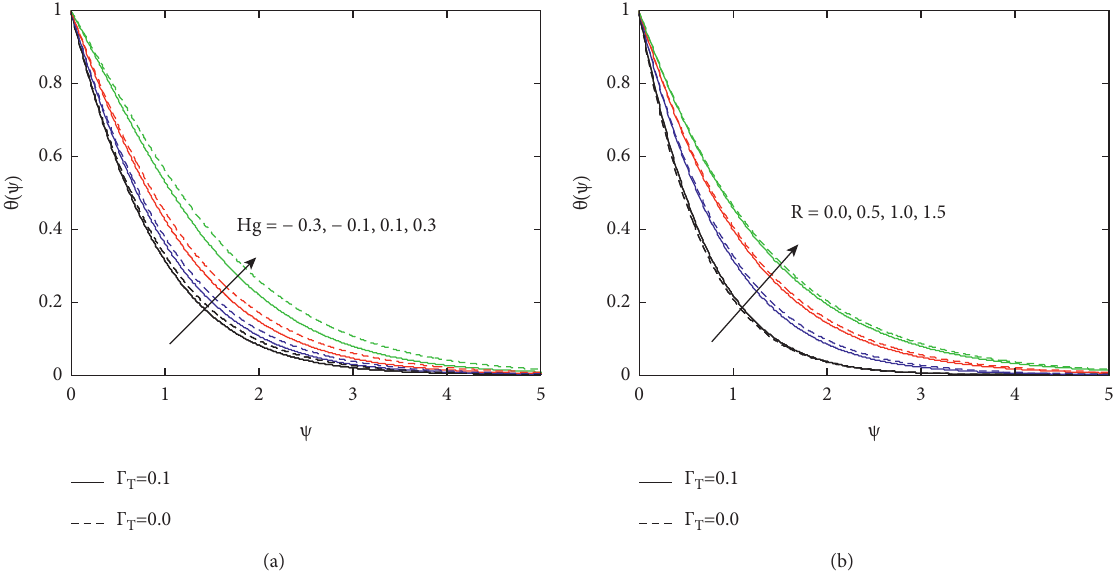
Figure 6: The temperature distribution for diverse quantity of Hg (a) and R